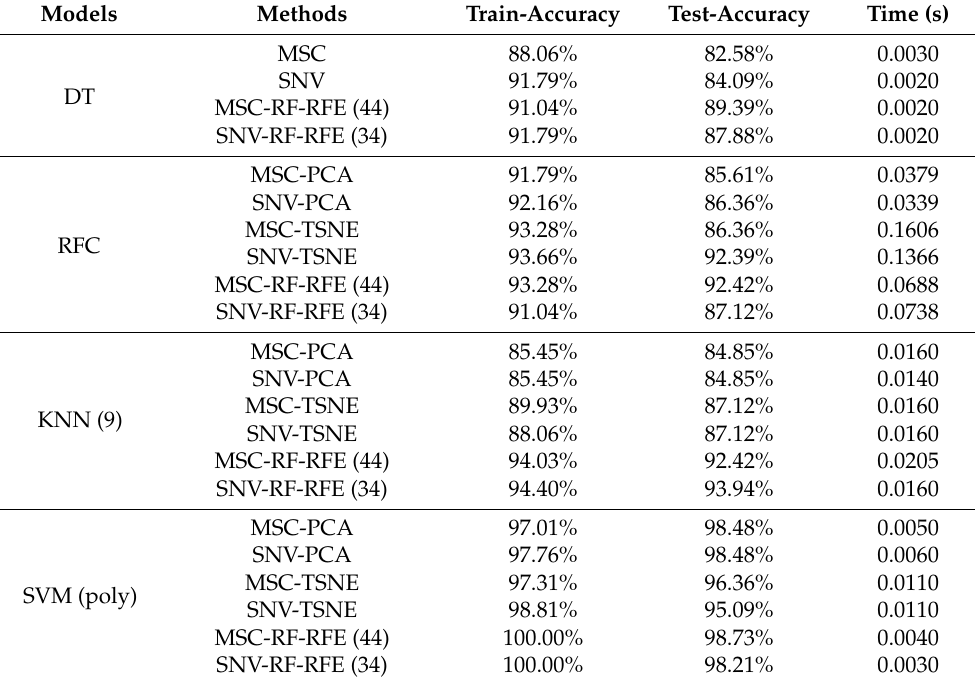
Table 4. Results of various classification